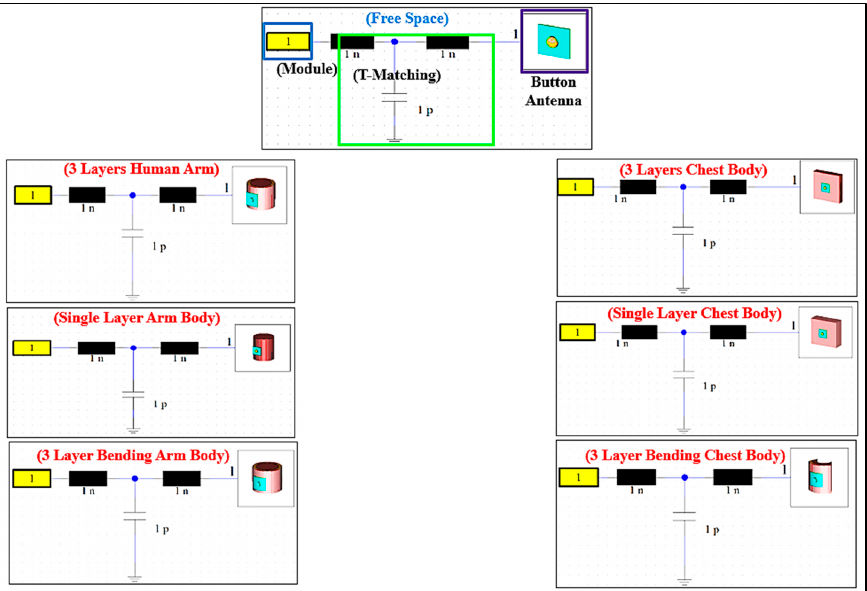
Figure 10. Set up for the 3-layer on-body cases considered for various testing purposes.